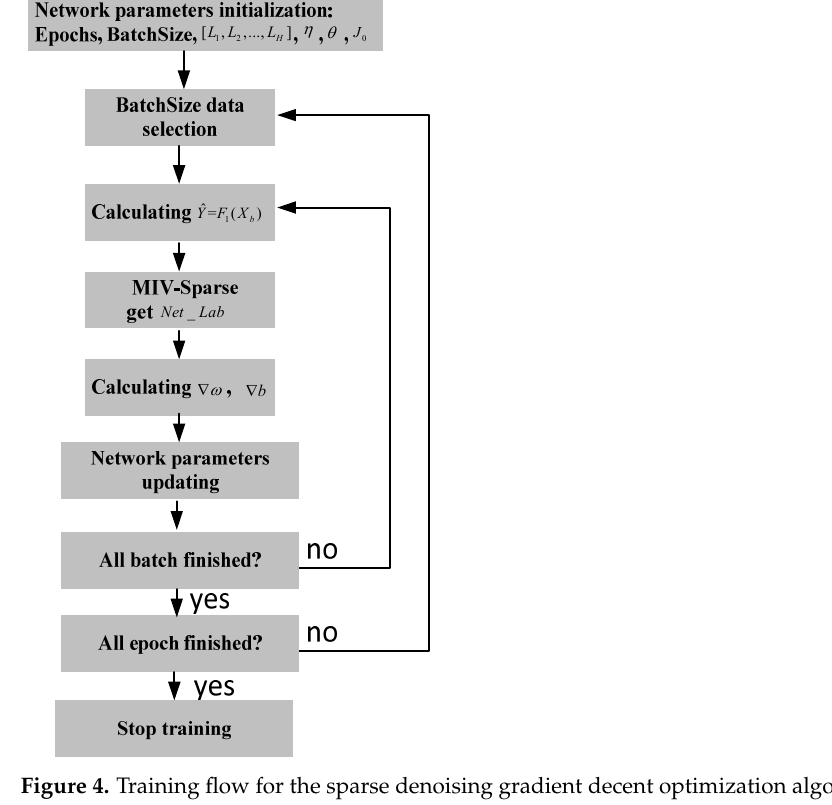
Figure 3. Structure diagram of SDGD optimized diagnosis network. The training flow for the sparse denoising gradient decent optimization algorithm is shown in Figure 4.